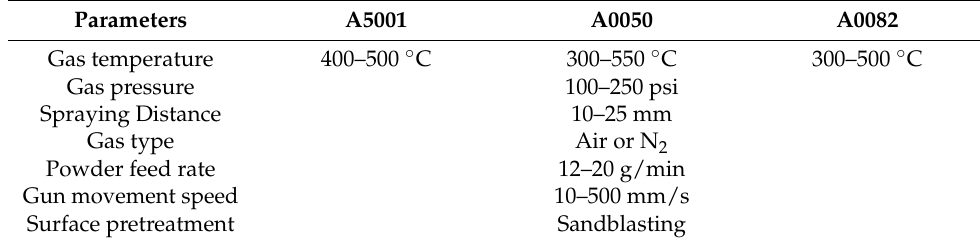
Table 2. Spraying process